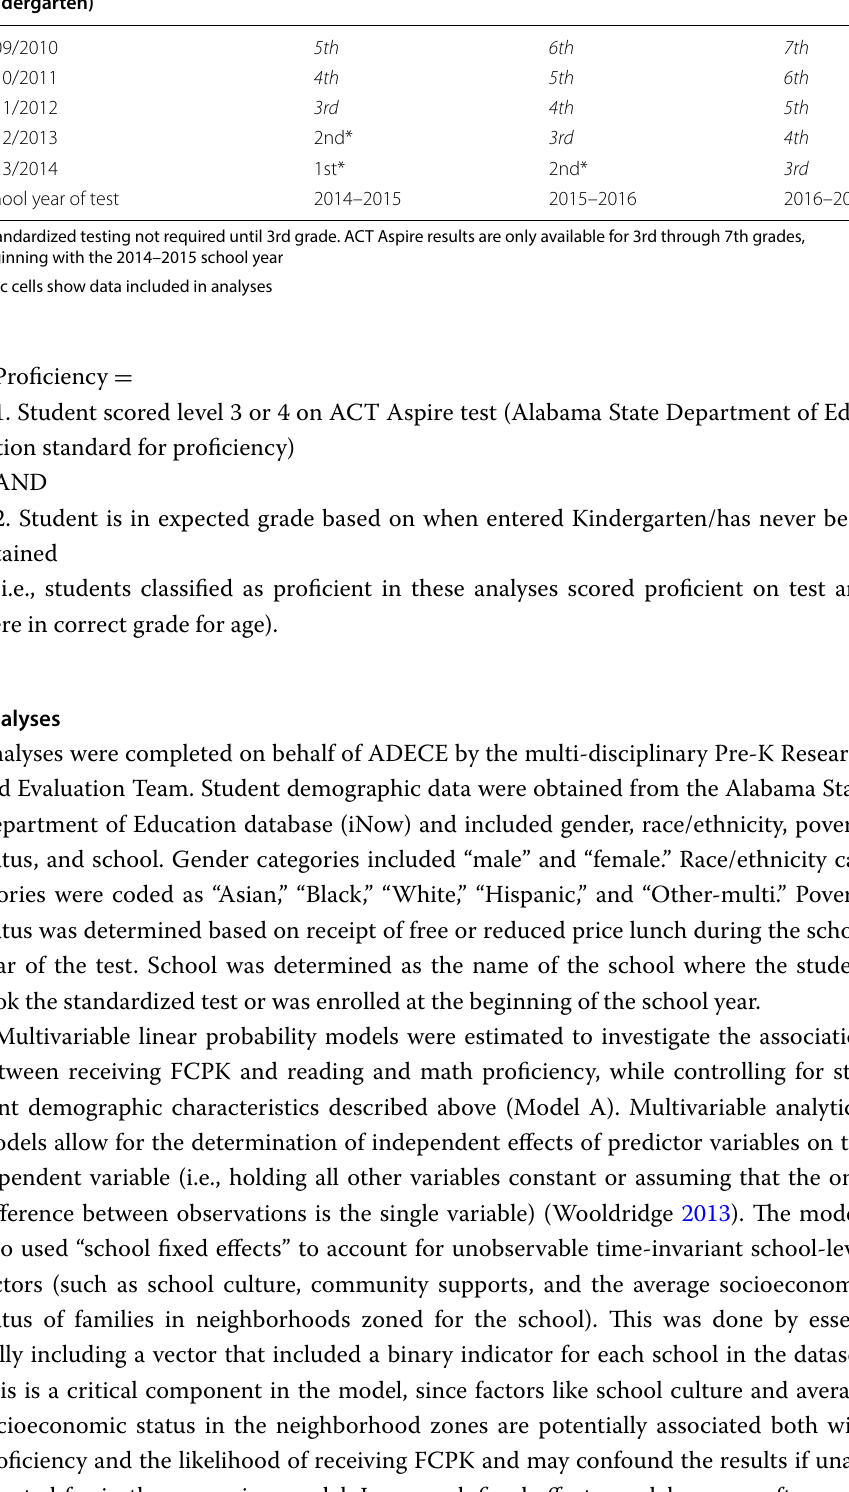
Table 1 Data structure by cohort, expected grade, and school year of test Cohort (based on year entered